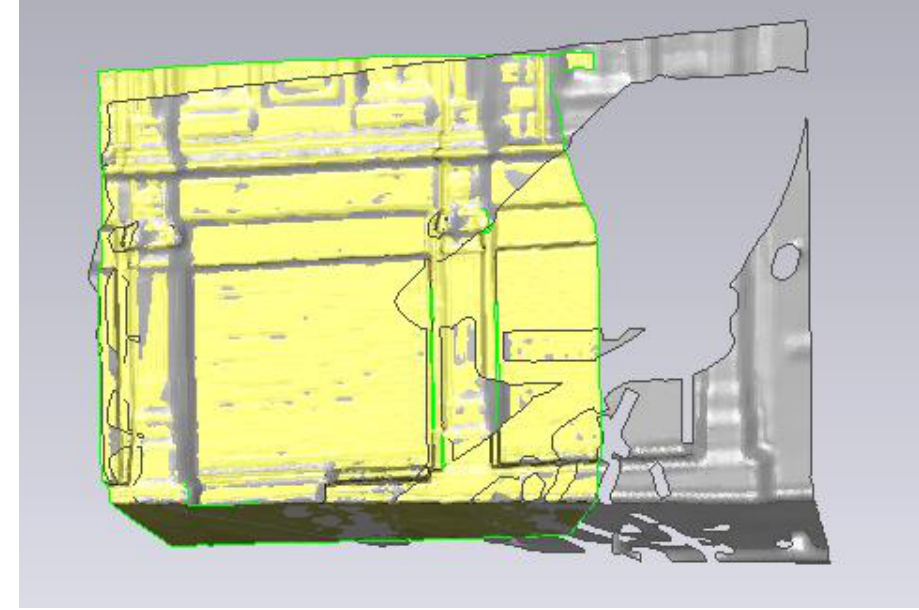
Figure 2. Historical building facade by TLS registration